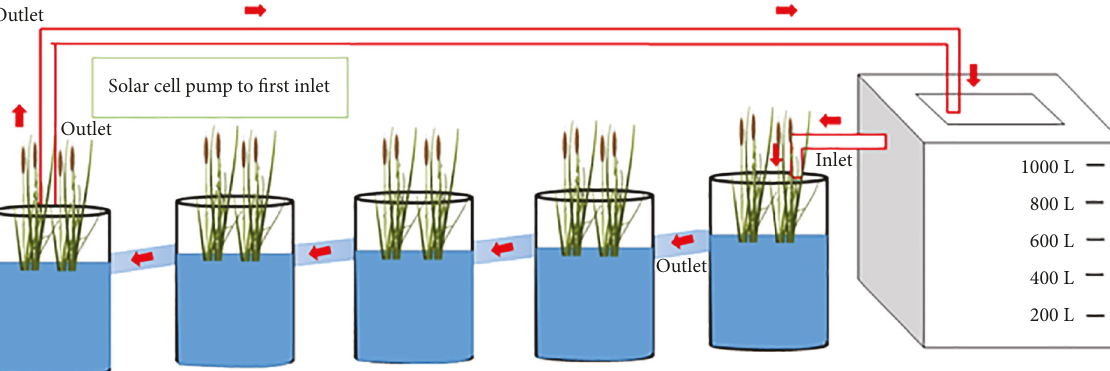
Figure 2: The series of HSFCWs with emergent plant